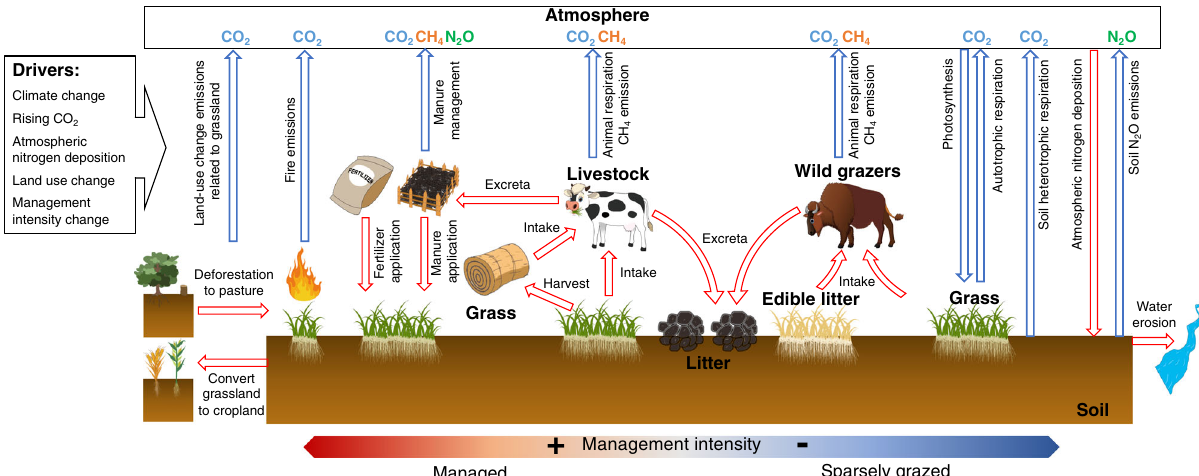
Fig. 1 Illustration of the processes and the greenhouse gas fl uxes that are accounted for in this study. The box with an arrow in the top left of the fi gure presents the drivers that used as input to the ORCHIDEE-GM v3.2. The processes and the greenhouse gas fl uxes that are related to grassland are shown as red and blue arrows, respectively. The red-to-blue layout at the bottom of the fi gure indicates management intensity from high (red; intensively managed grassland) to low (blue; sparsely grazed and natural